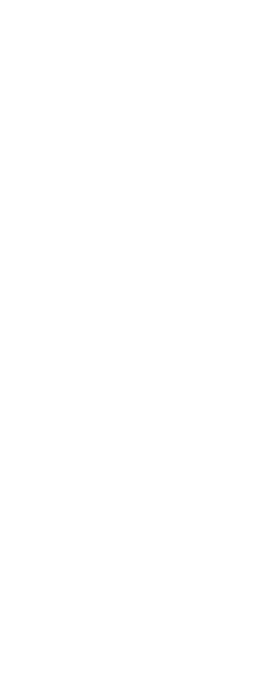
Figure 1 Factors affecting GPs’ confidence and engagement in melanoma management.SLNB = sentinel lymph node